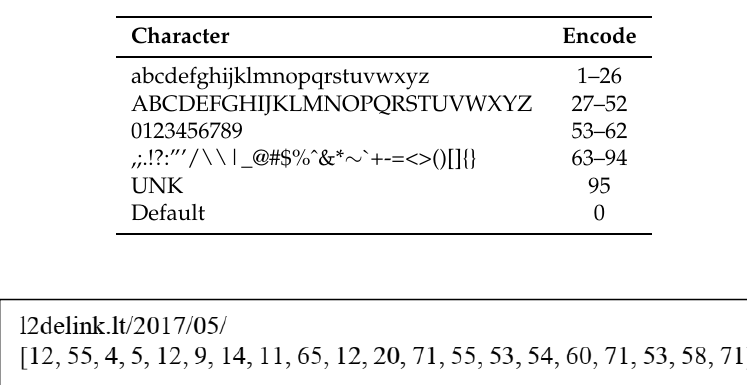
Table 1. Character dictionary.